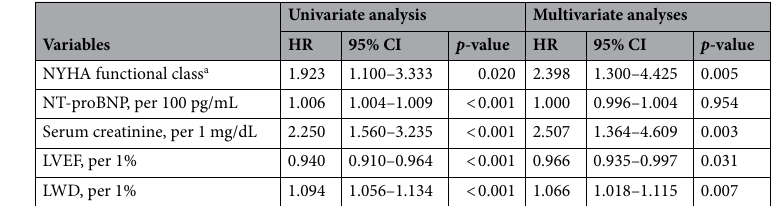
Table 3. Univariate and multivariate Cox regression model for the primary composite endpoint. All variables (except NYHA functional class) were assessed as continuous variables. a NYHA III–IV versus I–II; CI confidence interval, HR hazard ratio, LVEF left ventricular ejection fraction, LWD lung water density